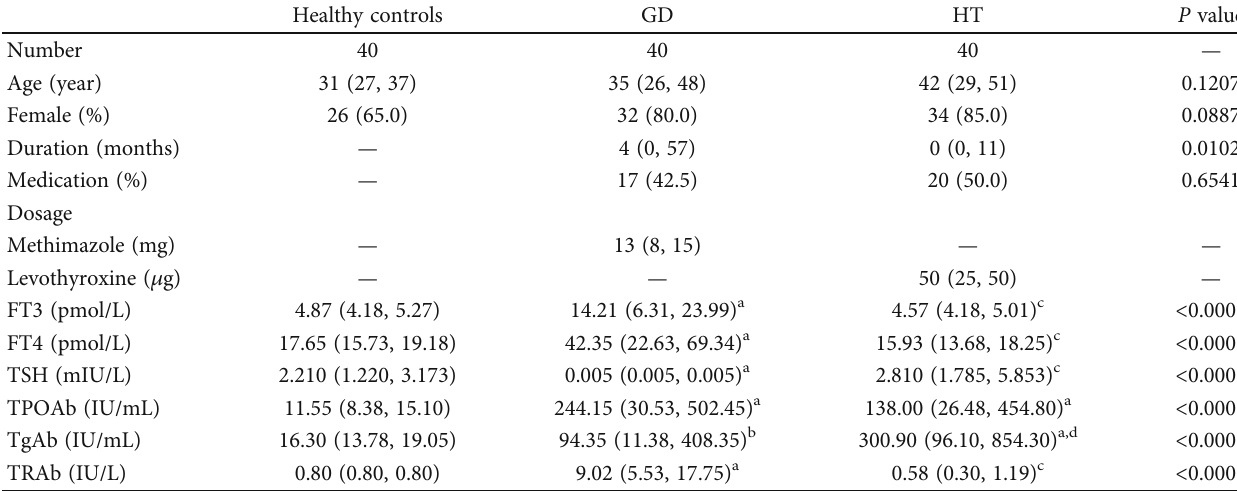
Table 1: Baseline characteristics of subjects with peripheral blood samples. Healthy controls GD HT